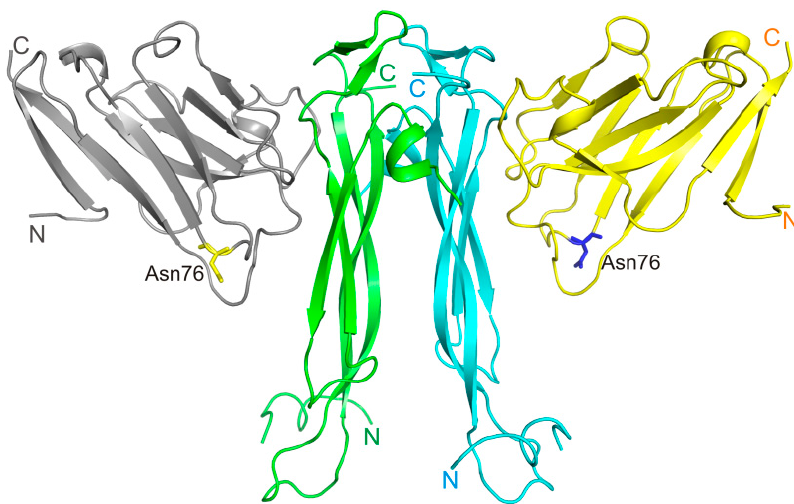
Figure 1. The structure of IL-17A/anti-IL-17A-76 complex (PDB code 8B7W). IL-17A monomers are shown in blue and green, anti-IL-17A-76—in yellow and grey.